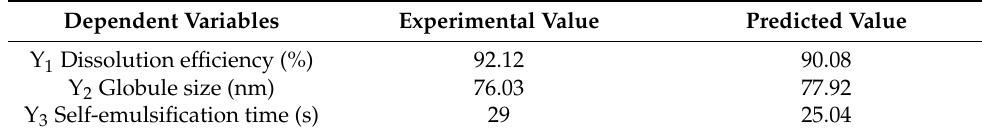
Figure 7. Overlay plot for checkpoint batch using design space. Table 5. Predicted and experimental values of Y 1 , Y 2, and Y 3 variables of checkpoint